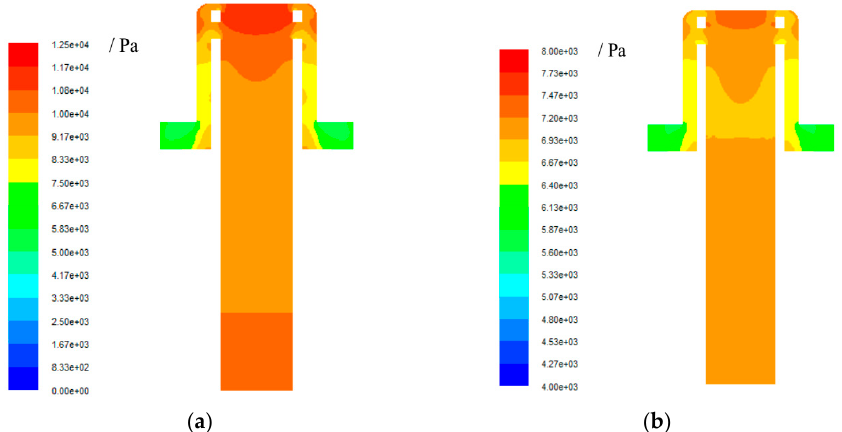
Figure 10. Pressure field of nozzle A and nozzle A3: ( a ) nozzle A3 (100% load); ( b ) nozzle A3 (30% load).